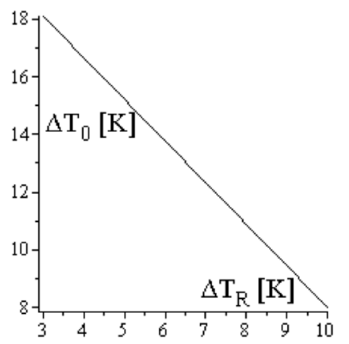
Figure 10. ∆ T 0 dependence of ∆ T R —case Figure 10. Δ T 0 dependence of Δ T R —case “d”. Figure 10. Δ T 0 dependence of Δ T R —case “d”. Figure 10. Δ T 0 dependence of Δ T R —case “d”. Figure 10. Δ T 0 dependence of Δ T R —case “d”.